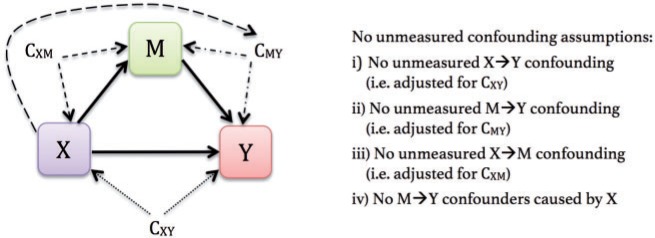
Assumptions required for estimating causal mediation effects from a model with exposure \documentclass[12pt]{minimal}
\usepackage{amsmath}
\usepackage{wasysym}
\usepackage{amsfonts}
\usepackage{amssymb}
\usepackage{amsbsy}
\usepackage{upgreek}
\usepackage{mathrsfs}
\setlength{\oddsidemargin}{-69pt}
\begin{document}
}{}$X$\end{document}, mediator \documentclass[12pt]{minimal}
\usepackage{amsmath}
\usepackage{wasysym}
\usepackage{amsfonts}
\usepackage{amssymb}
\usepackage{amsbsy}
\usepackage{upgreek}
\usepackage{mathrsfs}
\setlength{\oddsidemargin}{-69pt}
\begin{document}
}{}$M$\end{document}, and outcome \documentclass[12pt]{minimal}
\usepackage{amsmath}
\usepackage{wasysym}
\usepackage{amsfonts}
\usepackage{amssymb}
\usepackage{amsbsy}
\usepackage{upgreek}
\usepackage{mathrsfs}
\setlength{\oddsidemargin}{-69pt}
\begin{document}
}{}$Y$\end{document}. \documentclass[12pt]{minimal}
\usepackage{amsmath}
\usepackage{wasysym}
\usepackage{amsfonts}
\usepackage{amssymb}
\usepackage{amsbsy}
\usepackage{upgreek}
\usepackage{mathrsfs}
\setlength{\oddsidemargin}{-69pt}
\begin{document}
}{}$C_{XY}$\end{document} represents confounding variables of the \documentclass[12pt]{minimal}
\usepackage{amsmath}
\usepackage{wasysym}
\usepackage{amsfonts}
\usepackage{amssymb}
\usepackage{amsbsy}
\usepackage{upgreek}
\usepackage{mathrsfs}
\setlength{\oddsidemargin}{-69pt}
\begin{document}
}{}$X\rightarrow Y$\end{document} relationship, \documentclass[12pt]{minimal}
\usepackage{amsmath}
\usepackage{wasysym}
\usepackage{amsfonts}
\usepackage{amssymb}
\usepackage{amsbsy}
\usepackage{upgreek}
\usepackage{mathrsfs}
\setlength{\oddsidemargin}{-69pt}
\begin{document}
}{}$C_{MY}$\end{document} represents confounders of the \documentclass[12pt]{minimal}
\usepackage{amsmath}
\usepackage{wasysym}
\usepackage{amsfonts}
\usepackage{amssymb}
\usepackage{amsbsy}
\usepackage{upgreek}
\usepackage{mathrsfs}
\setlength{\oddsidemargin}{-69pt}
\begin{document}
}{}$M\rightarrow Y$\end{document} relationship, and \documentclass[12pt]{minimal}
\usepackage{amsmath}
\usepackage{wasysym}
\usepackage{amsfonts}
\usepackage{amssymb}
\usepackage{amsbsy}
\usepackage{upgreek}
\usepackage{mathrsfs}
\setlength{\oddsidemargin}{-69pt}
\begin{document}
}{}$C_{XM}$\end{document} represents confounders of the \documentclass[12pt]{minimal}
\usepackage{amsmath}
\usepackage{wasysym}
\usepackage{amsfonts}
\usepackage{amssymb}
\usepackage{amsbsy}
\usepackage{upgreek}
\usepackage{mathrsfs}
\setlength{\oddsidemargin}{-69pt}
\begin{document}
}{}$X\rightarrow M$\end{document} relationship. To estimate causal mediation effects, the researcher assumes that he has controlled for \documentclass[12pt]{minimal}
\usepackage{amsmath}
\usepackage{wasysym}
\usepackage{amsfonts}
\usepackage{amssymb}
\usepackage{amsbsy}
\usepackage{upgreek}
\usepackage{mathrsfs}
\setlength{\oddsidemargin}{-69pt}
\begin{document}
}{}$C_{XY}, C_{MY}, C_{XM}$\end{document} and that there are no M\documentclass[12pt]{minimal}
\usepackage{amsmath}
\usepackage{wasysym}
\usepackage{amsfonts}
\usepackage{amssymb}
\usepackage{amsbsy}
\usepackage{upgreek}
\usepackage{mathrsfs}
\setlength{\oddsidemargin}{-69pt}
\begin{document}
}{}$\rightarrow$\end{document}Y confounders caused by \documentclass[12pt]{minimal}
\usepackage{amsmath}
\usepackage{wasysym}
\usepackage{amsfonts}
\usepackage{amssymb}
\usepackage{amsbsy}
\usepackage{upgreek}
\usepackage{mathrsfs}
\setlength{\oddsidemargin}{-69pt}
\begin{document}
}{}$X$\end{document}. Identifying CDEs requires that assumptions (i) and (ii) be met. Identifying NDEs and NIEs requires that all four assumptions be met. Figure adapted from VanderWeele’s 2015 book Explanation in Causal Inference: Methods for Mediation and Interaction.